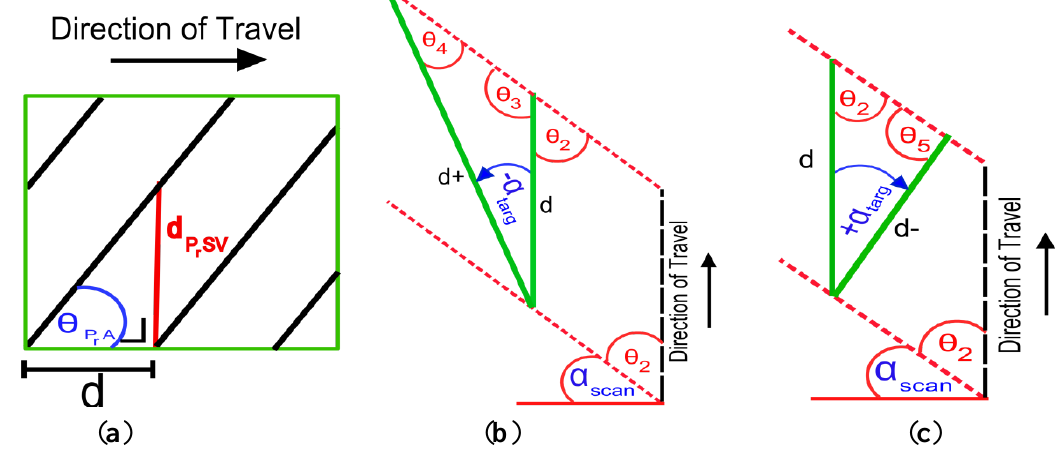
Figure 4. Calculating profile spacing ( a ) profile spacing on a parallel vertical surface ( b ) aerial view of surface rotated away from the MMS-profile spacing increases ( c ) target is rotated towards the MMS-profile spacing